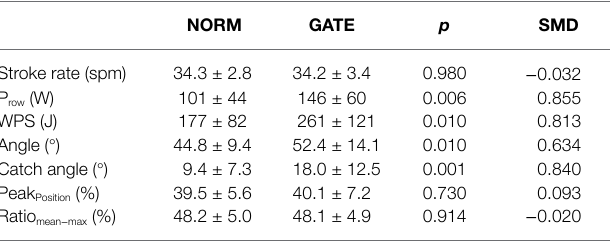
TABLE 1 | Output parameter of the proof-of-concept testing (indoor rowing tank measurements).